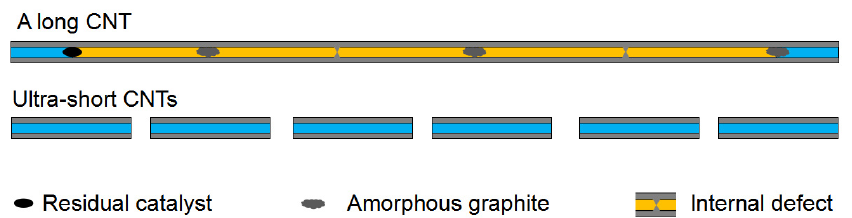
Figure 6. A schematic comparing the filling capacity of raw long CNTs and ultra-short CNTs.